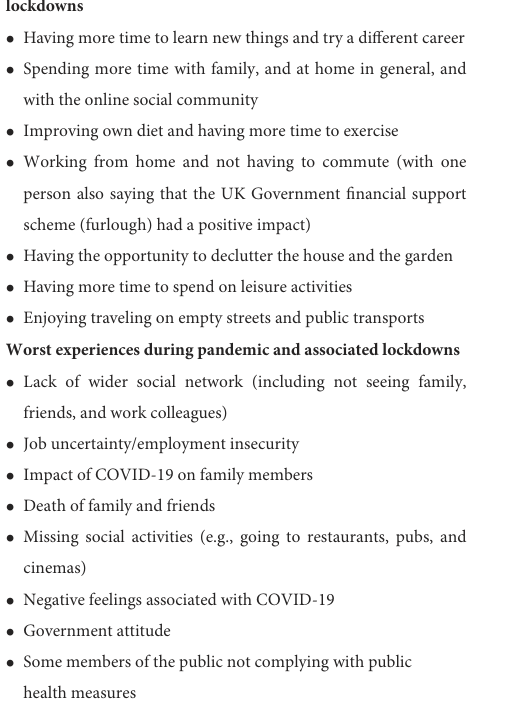
TABLE 6 Best and worst experiences during the pandemic and associated lockdowns. Bestexperiencesduring the pandemic and associated lockdowns